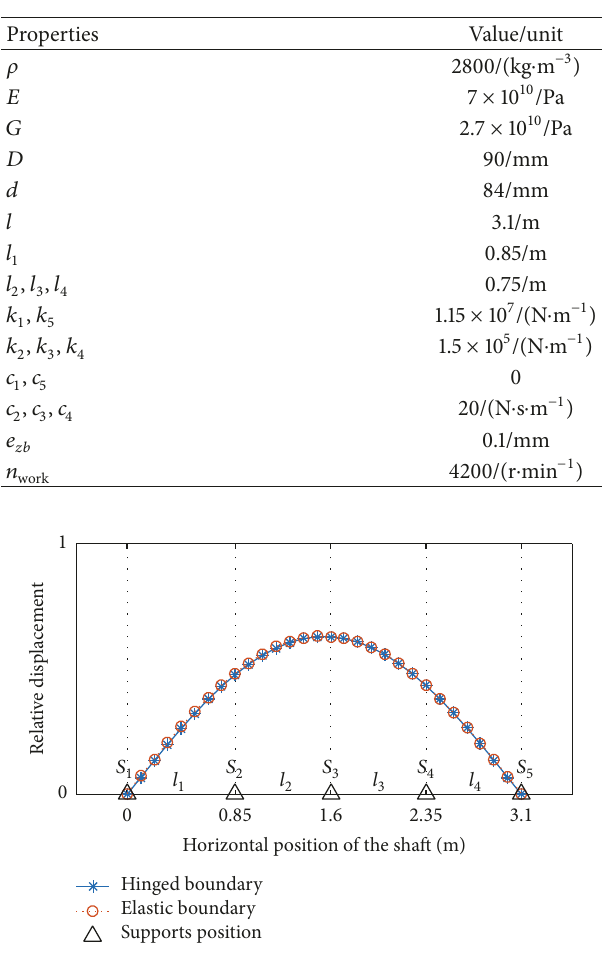
Table 1: Typical parameters of a helicopter tail-shaft.